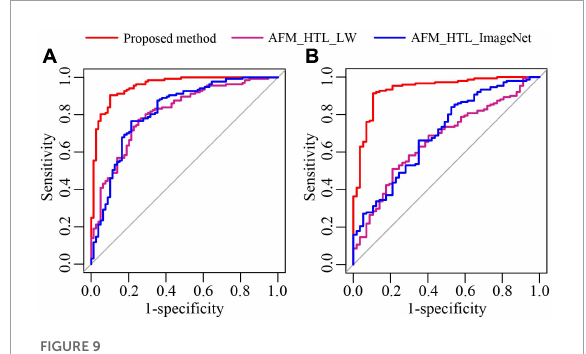
FIGURE9 The ROC curves of the proposed method and transfer learning models based on different source domains. (A) ROC of test cohort 1; (B) ROC of test cohort